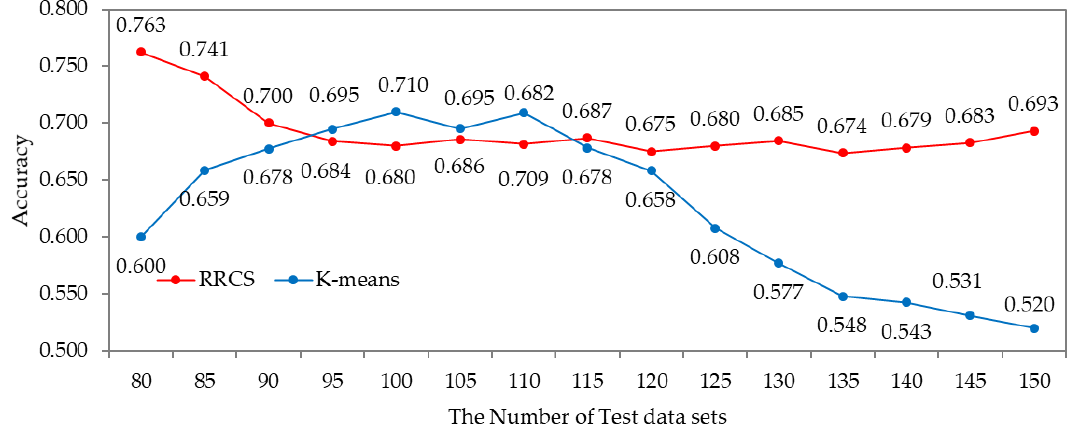
Figure 7. The misclassification errors of the RRCS.